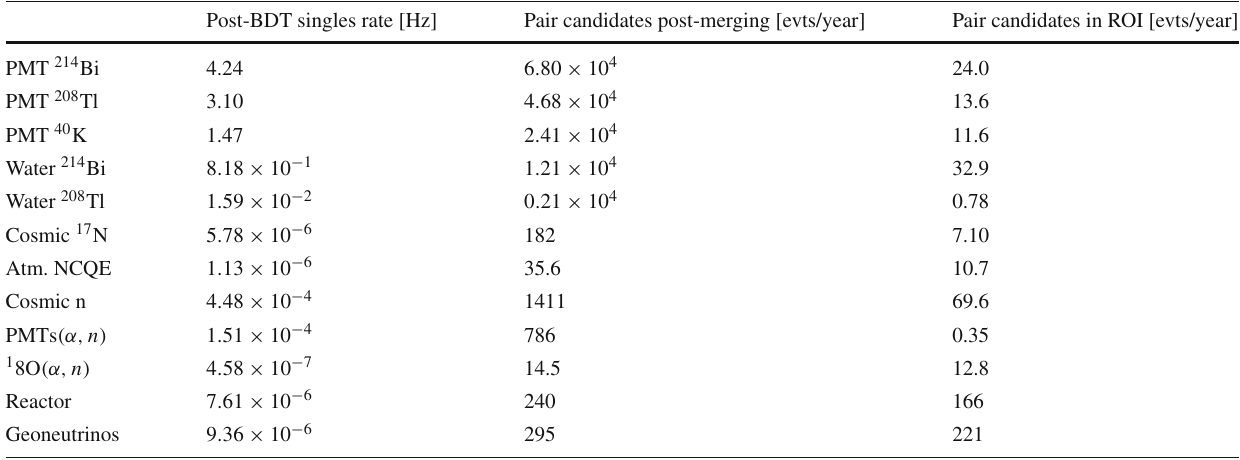
( Δ t = 1ms and Δ R = 3m), and contributions of each component in the Region-of-Interest (ROI), optimized for geo- and reactor neutrinos signal, described in the following section